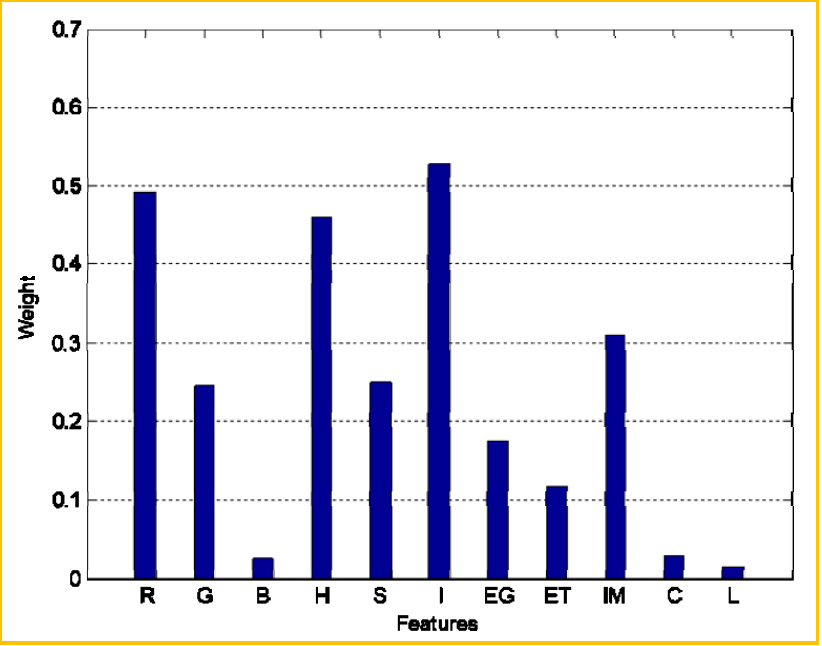
Figure 7. Resulting weight vector for the eleven extracted features. EG: Energy; ET: Entropy; IM: Inertial moment; C: Correlation; L: Local smoothing.